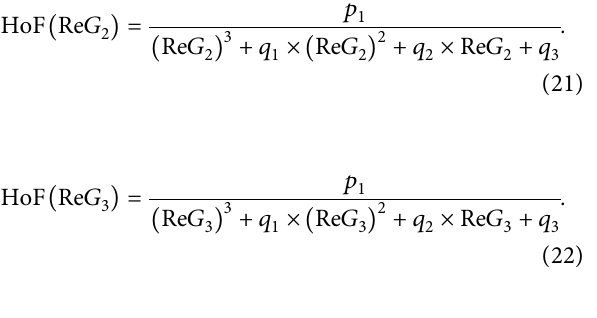
Figure 4: Comparison of indices F(G), AZI(G), and J(G) for TbO